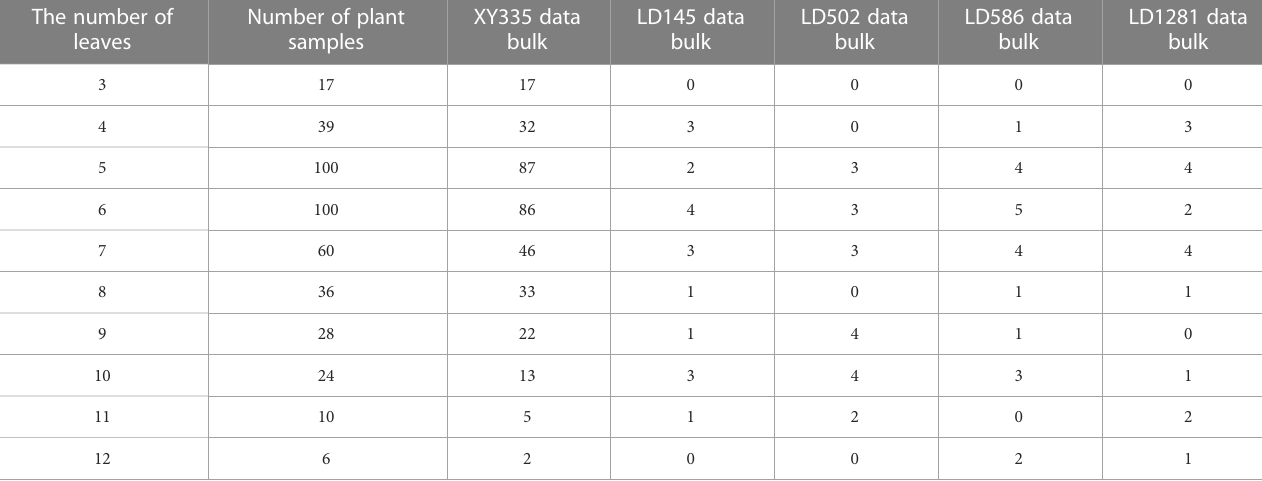
TABLE 1 Number of plant samples from different numbers of leaves in the various maize varieties. The number of leaves